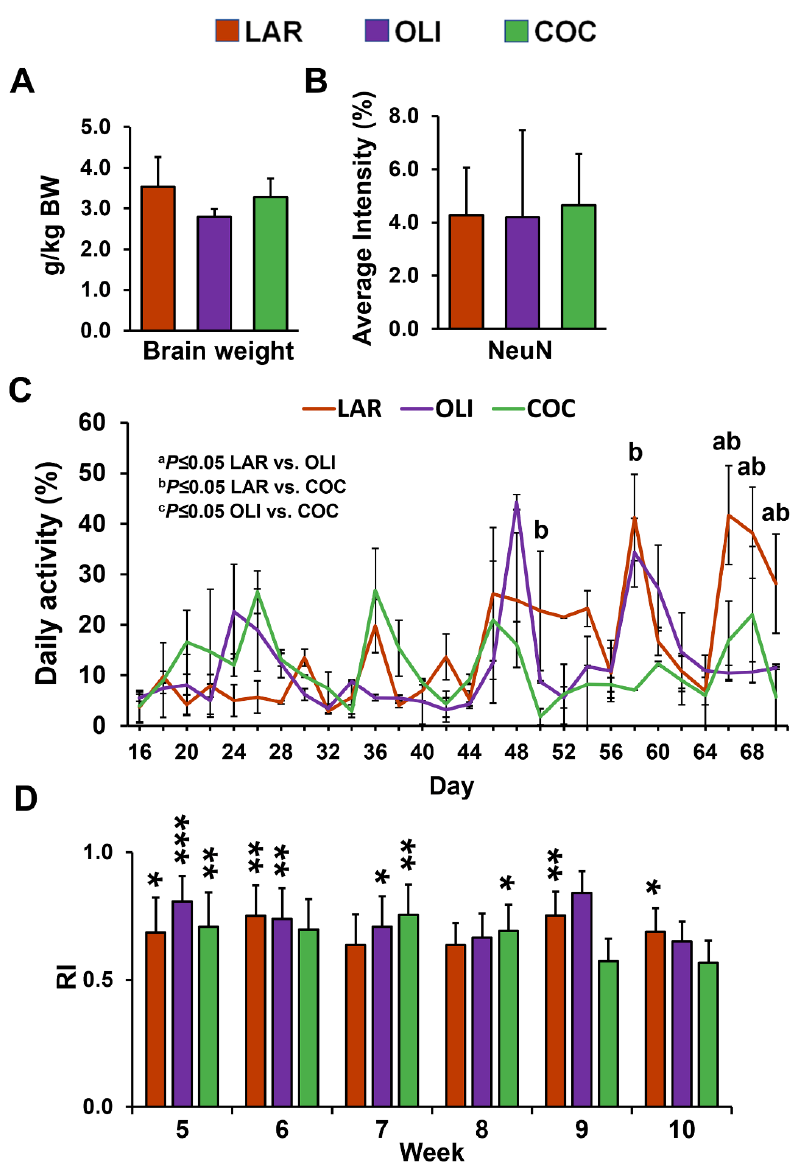
58 ( p ≤ 0.05), and in COC and OLI on d 66, 68, and 70 ( p ≤ 0.05; Figure 2C). There were no differences in the novel object recognition test between weeks 5 and 10 across treatment groups (Figure 2D). In addition, RI was significantly greater than 0.5 for all diets at week 5 ( p ≤ 0.05), for LAR and OLI at week 6 ( p ≤ 0.01), OLI and COC at week 7 ( p ≤ 0.05), COC for LAR and OLI at week 6 ( p ≤ 0.01), OLI and COC at week 7 ( p ≤ 0.05), COC at week 8 ( p at week 8 ( p ≤ 0.05), and LAR at weeks 9 and 10 ( p ≤ 0.05; Figure 2D). ≤ 0.05), and LAR at weeks 9 and 10 ( p ≤ 0.05; Figure 2D).